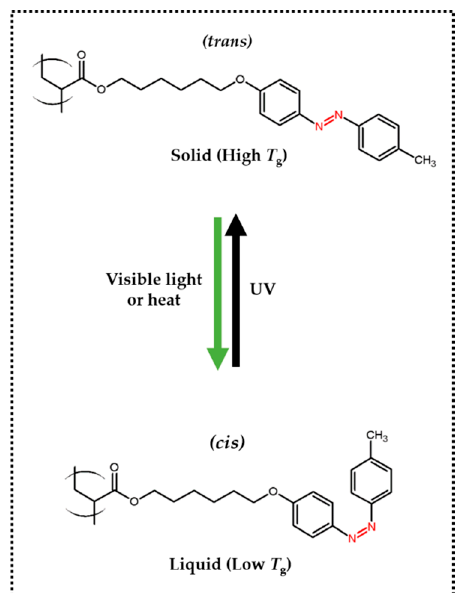
Figure 6. Schematic illustration and solid-to-liquid transitions of azobenzene-containing polymers developed by Zhou et al. [63].